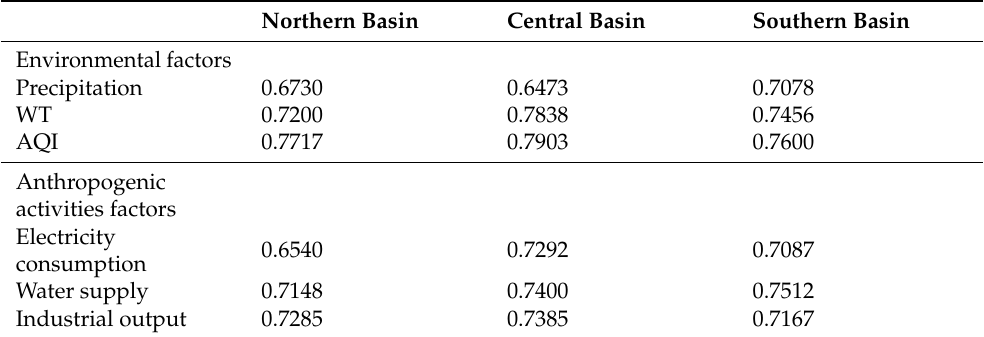
Table 1. Grey correlation between WQI and selected environmental or anthropogenic activity factors in Guangzhou reach of the Pearl